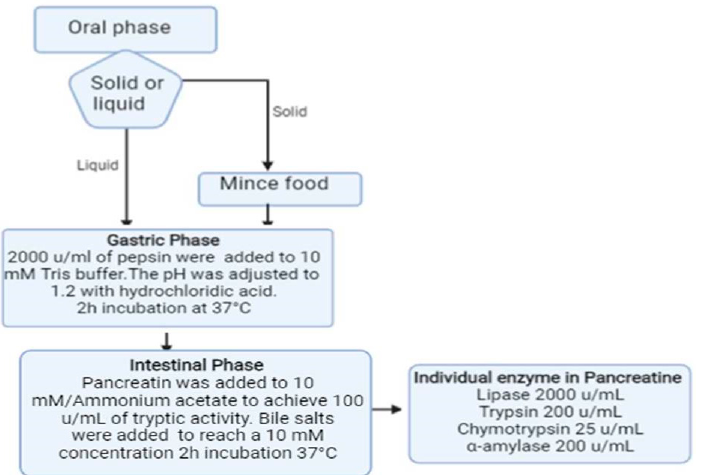
Figure 1. Schematic representation of the simulated digestion procedure set-up to study the production of peptides from Spirulina-containing aliments.